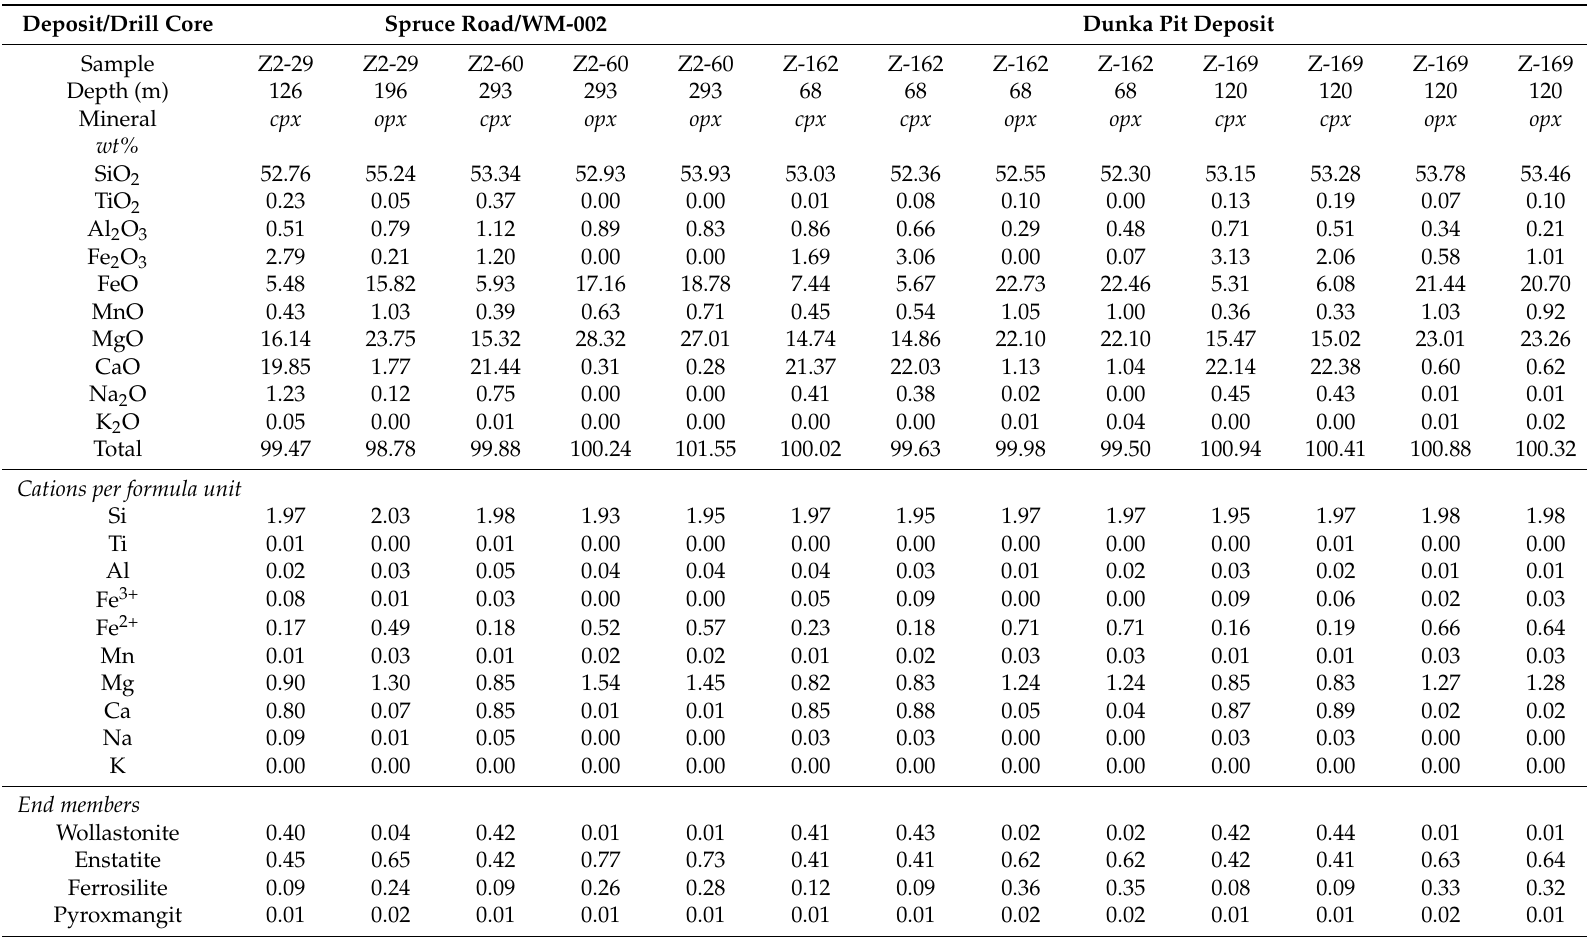
Table 1. Representative electron microprobe analyses of pyroxene